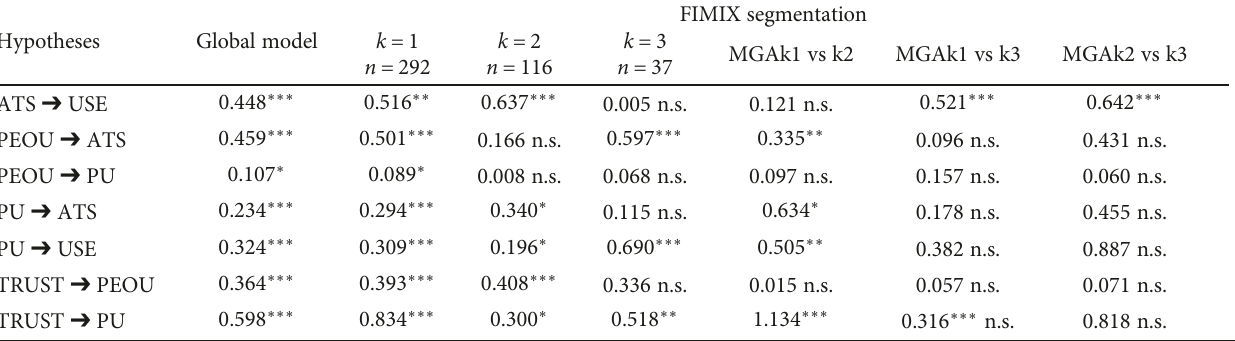
Table 11: Disaggregate results for direct e ff ects between latent variables.